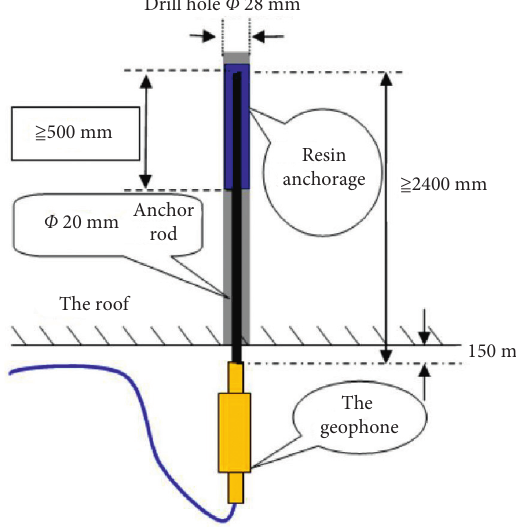
Figure 4: Installation diagram of roof geophone.